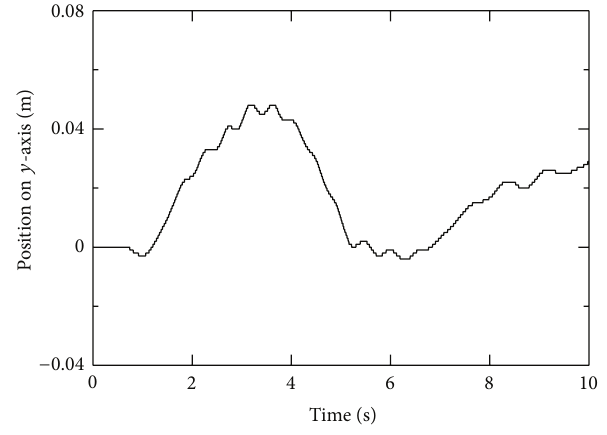
Figure 18: Position of 4th joint on 𝑦 -axis.